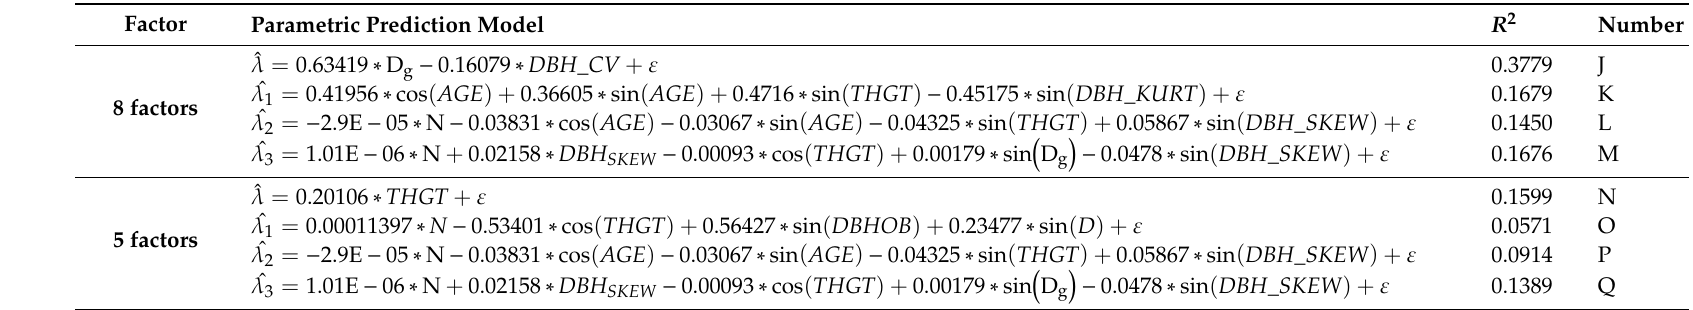
Table 9. Parametric prediction models and their prediction e ff